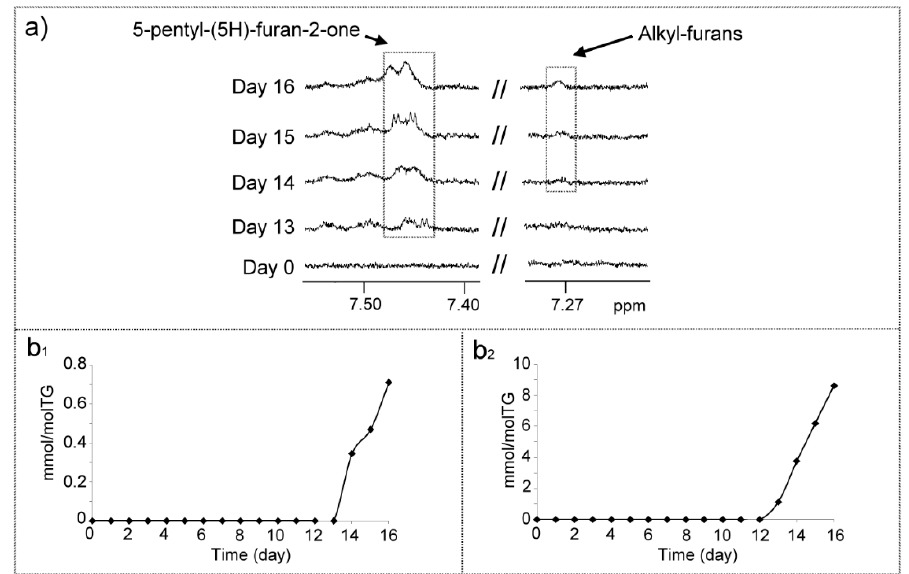
Figure 14. ( a ) Enlargement of a region of the 1 H NMR spectra region in which the signals of alkyl-furans and 5-pentyl-(5H)-furan-2-one appear. ( b ) Evolution of the concentration of alkyl-furans ( b 1 ) and 5-pentyl-(5H)-furan-2-one ( b 2 ), expressed as mmol/mol TG versus time given in days.